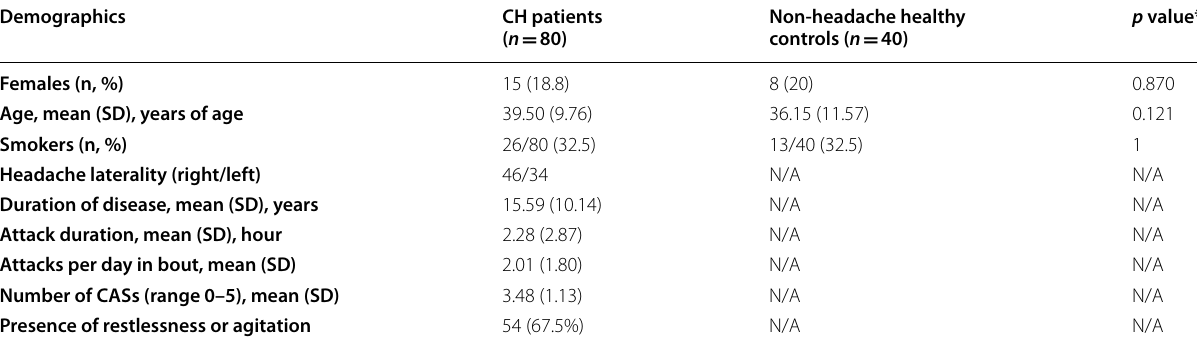
* Differences between continuous variables were analyzed by t-test, and the differences between categorical variables were analyzed by the chi-square test; p < 0.05 was considered statistically significant